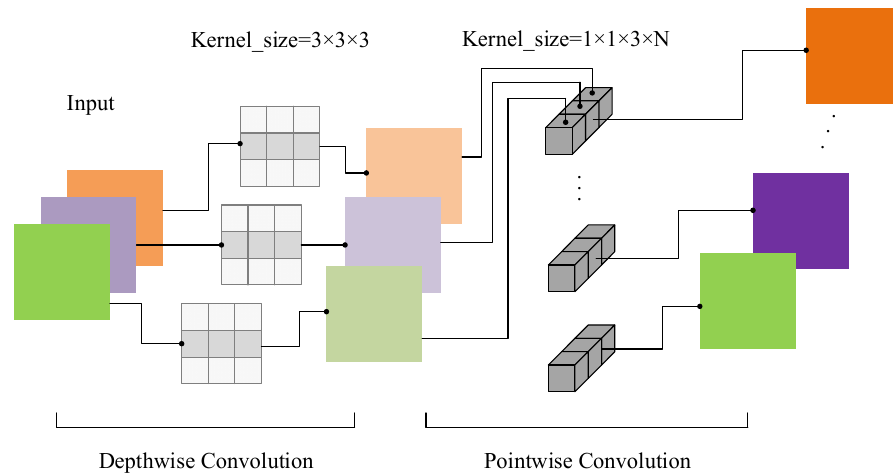
Figure 2. The depthwise separable convolution structure.